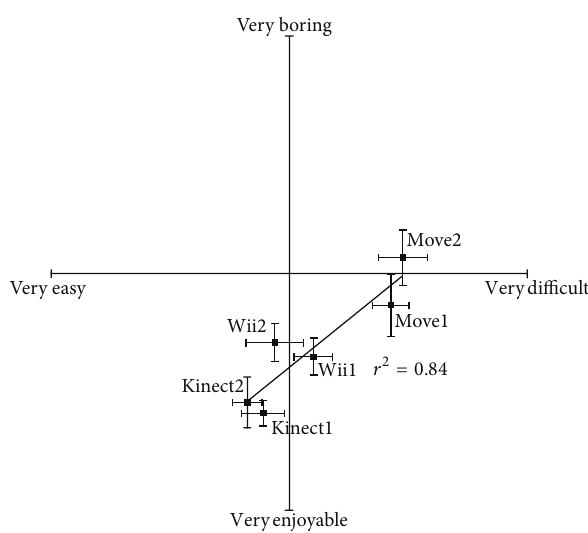
Figure 7: Group means ( 𝑛 = 11 ) for rating of game enjoyment plot- ted against rating of game difficulty for each separate dance routine and body motion sensing technology. Error bars indicate SEM. The data points were significantly correlated ( 𝑟 2 = 0.84 , 𝑃 < 0.05